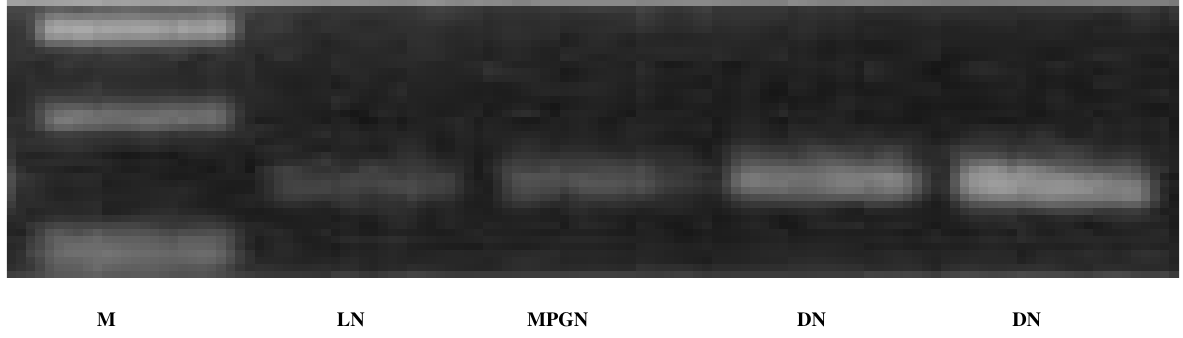
FIGURE 3. Ultraviolet transilluminated agarose gel electrophoresis shows PCR product of PKC α gene (104 bp) in different study groups (Lane M: PCR marker, Lane 2: LN case, Lane 3: MPGN case, Lanes 4 and 5: DN cases).